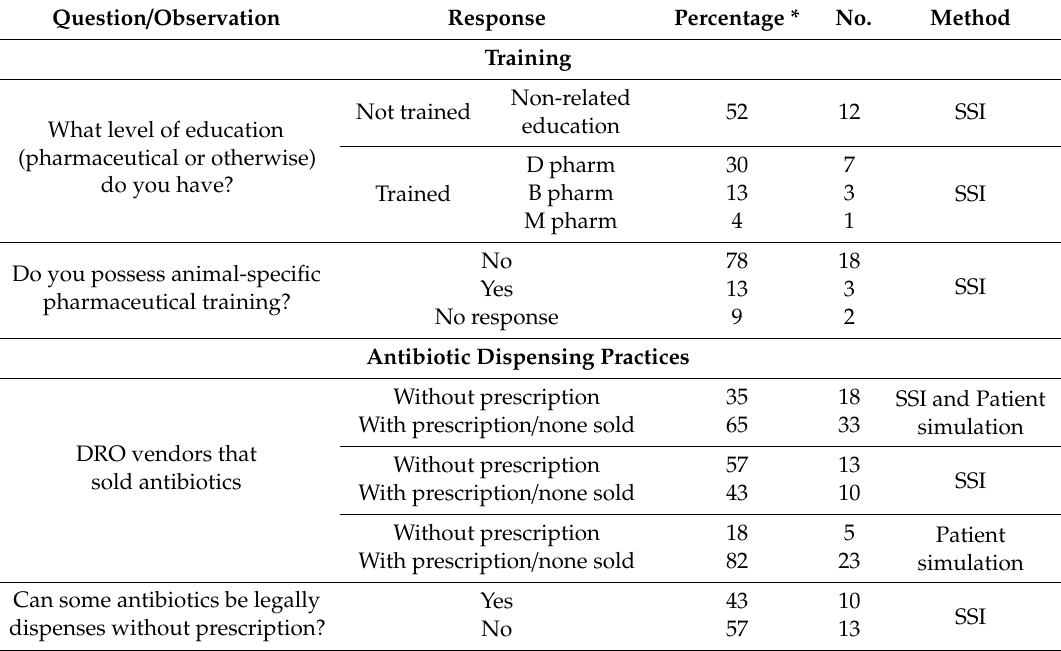
Table 1. Results outlining levels of training and antibiotic dispensing practices